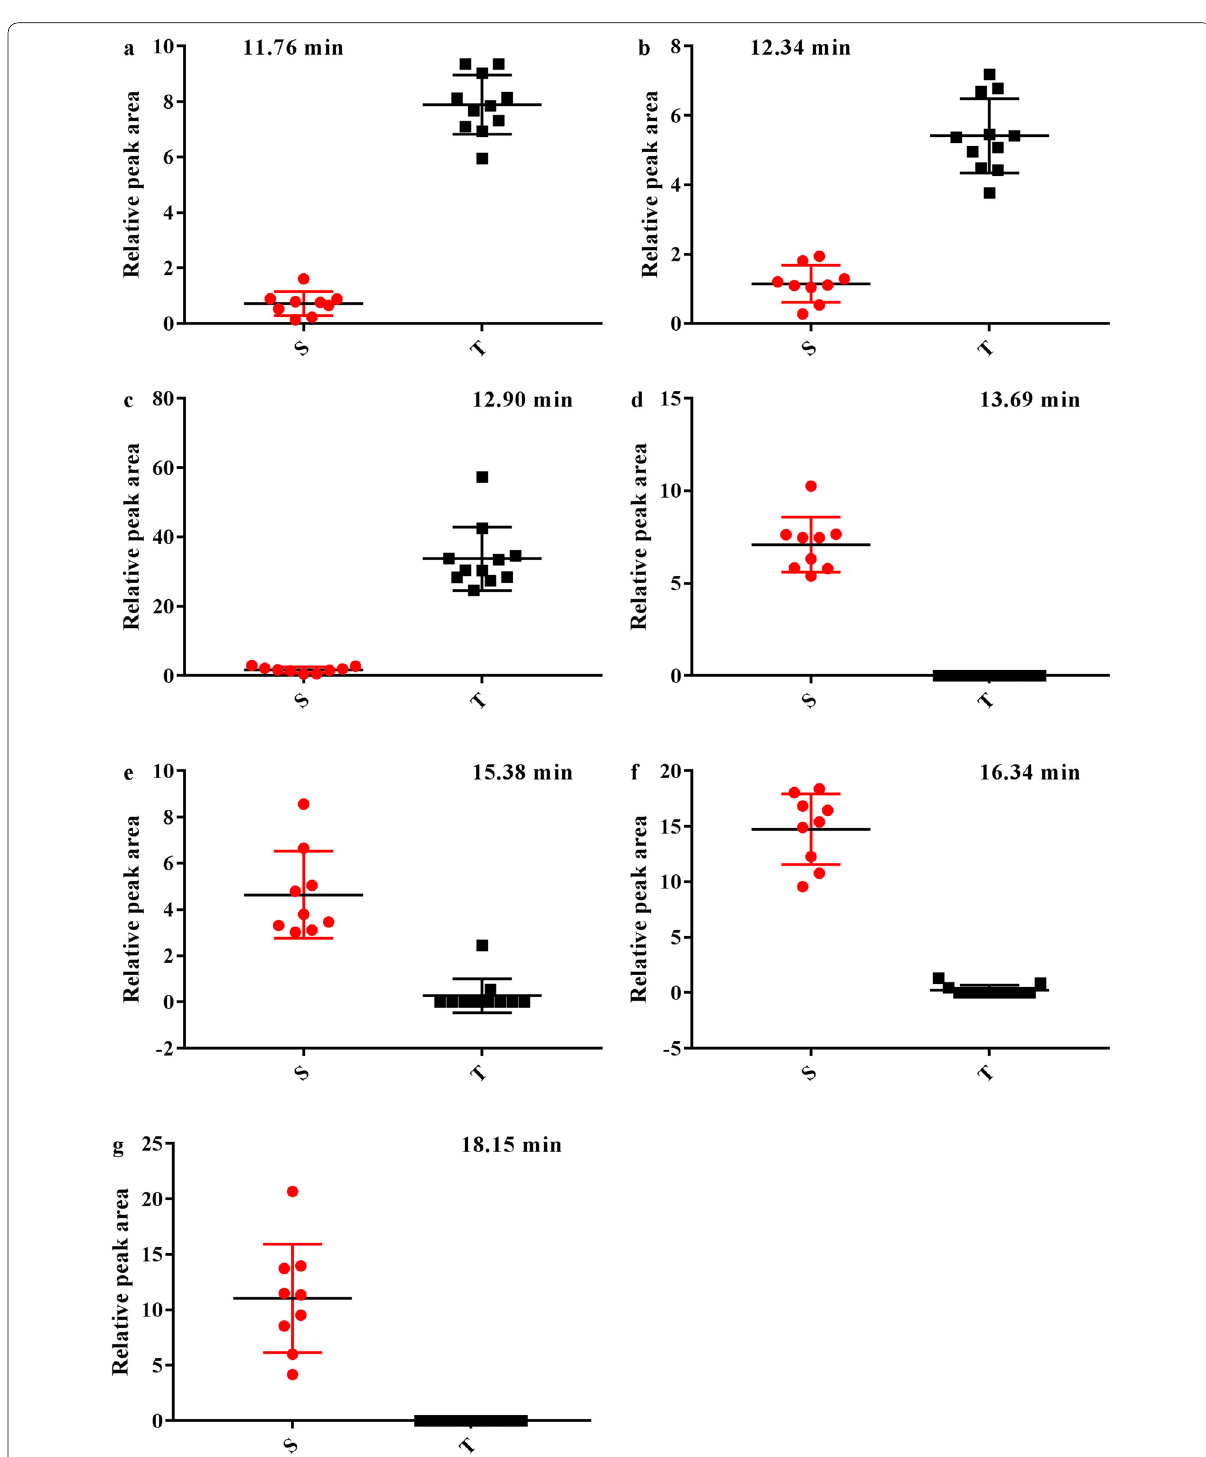
Fig. 6 Relative peak areas of seven peaks from the HS–GC–MS coupled with SNF. 11.76 min ( a ), 12.34 min ( b ), 12.90 min ( c ), 13.69 min ( d ), 15.38 min ( e ), 16.34 min ( f ), 18.15 min ( g ). Pterocarpus santalinus ( S ), Pterocarpus tinctorius ( T